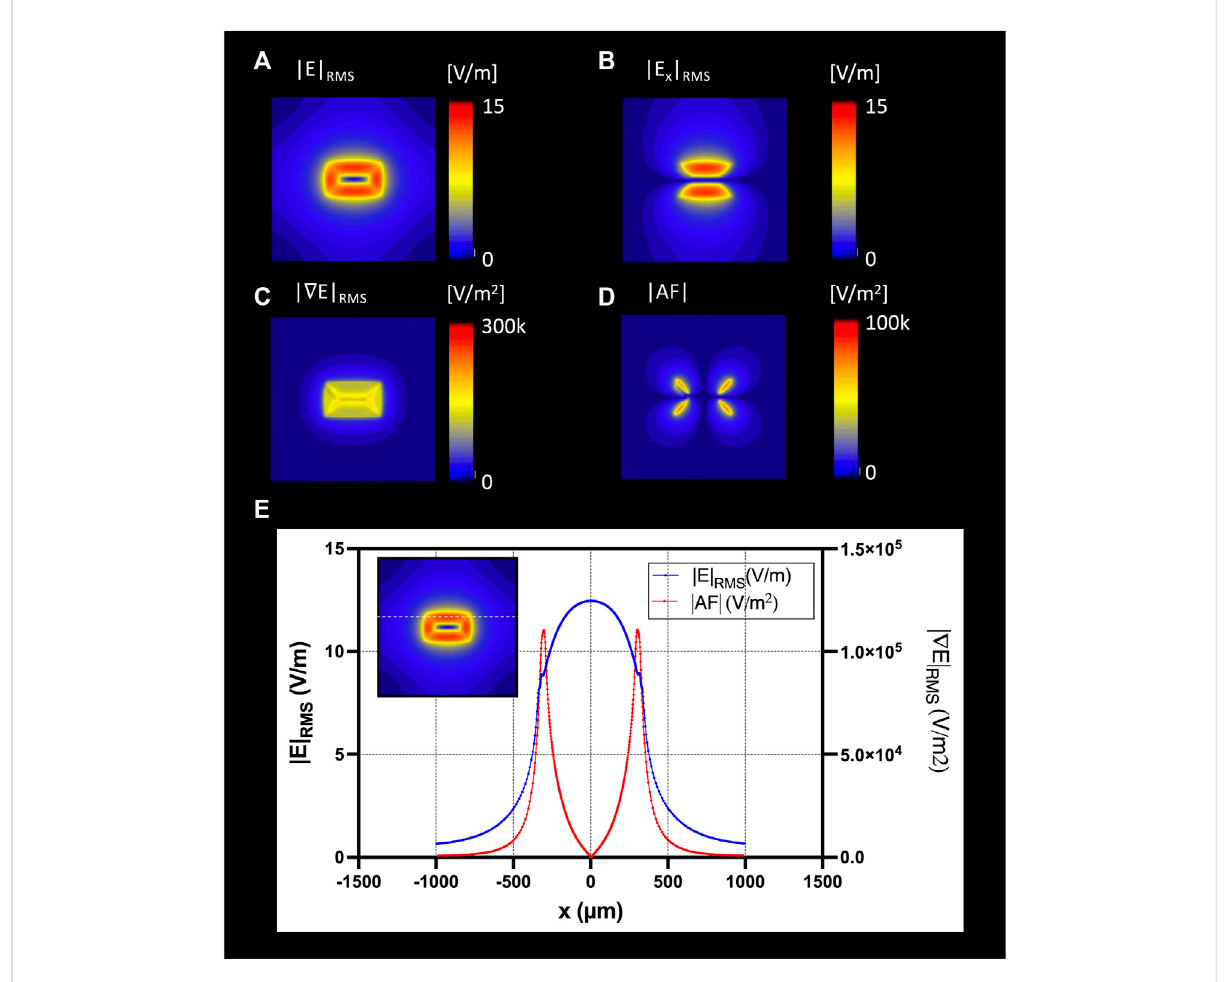
FIGURE 6 The optimal coil orientation was along the x -axis; Top view of the E- fi eld generation on the nerve surface with (A) |E|RMS; (B) |Ex|RMS; (C) gradient of ERMS; (D) Top view of the absolute Activating Fucntion (AF): spatial gradient of Ex in x -direction; (E) pro fi le of the |E|RMS (blue), and gradient of |E|RMS (red) along the nerve direction along the x